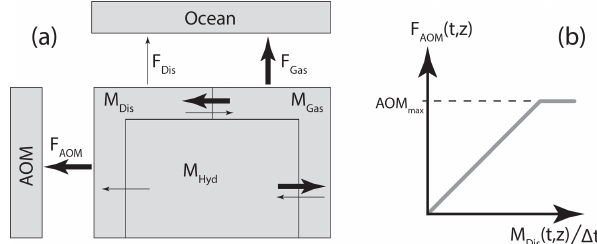
Figure 1. (a) A schematic overview of the three CH 4 mass pools within the sediments and the general direction of the CH 4 mass transport during hydrate dissociation, within and out of the system (illustrated by the thick arrows). (b) Modelled F AOM (t,z) as a func- tion of the dissolved CH 4 saturation (where (cid:49)t is the time step) and predefined AOM max .